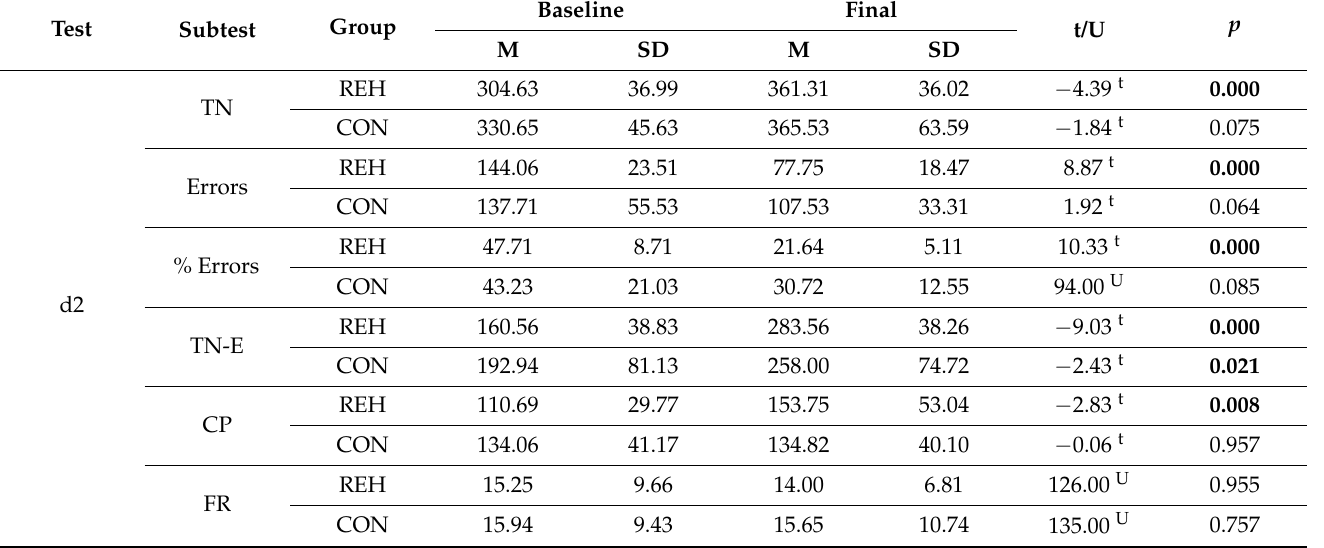
Table 2. T1 versus T2 neurocognitive tests, NPS and PANSS